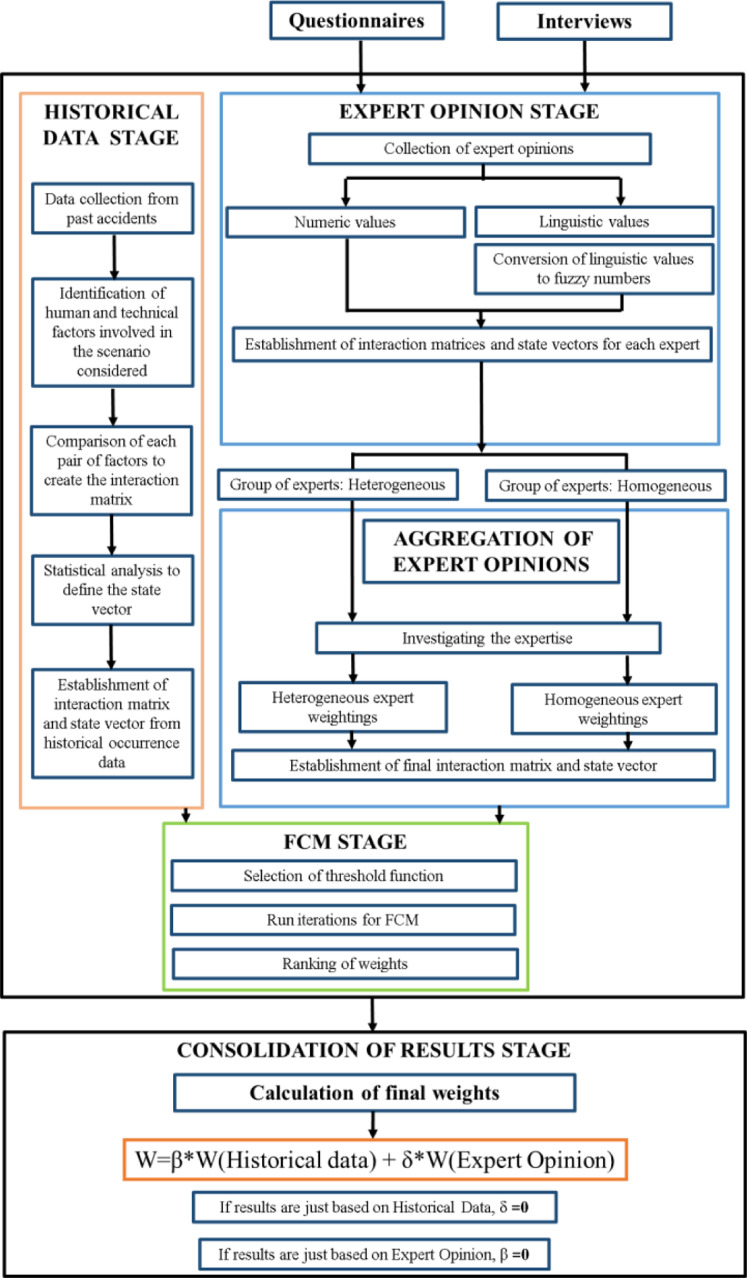
MALFCM overview.